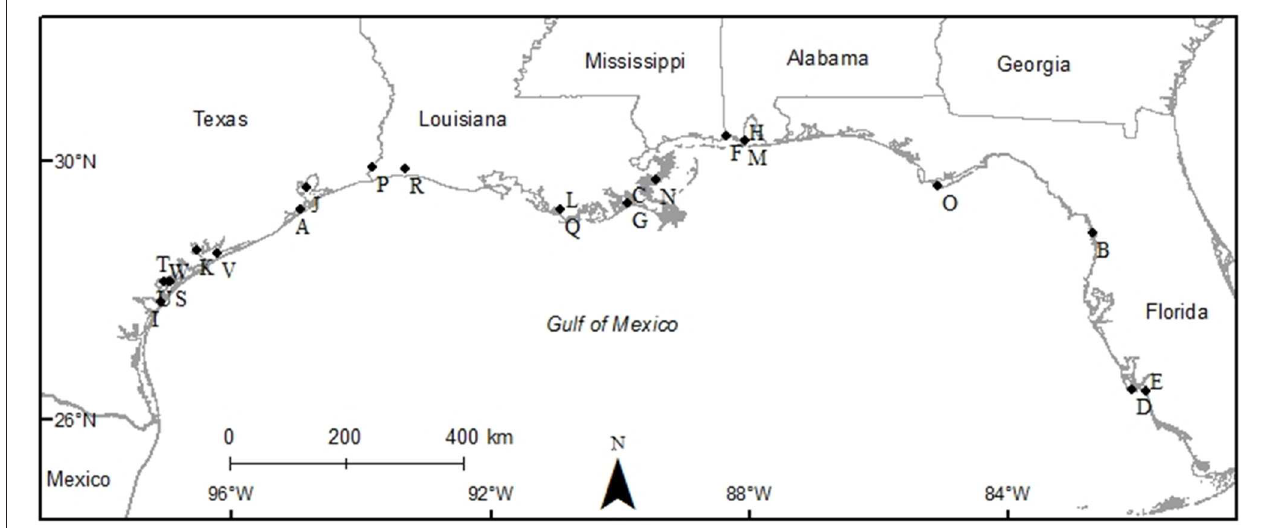
FIGURE 2 | Map of study sites used to examine the diversity and abundance of fish and decapod crustacean communities on oyster reefs across the northern coast of the Gulf of Mexico (Texas, Louisiana, Mississippi, Alabama, and Florida Gulf coast). See Table 1 for explanation of study codes.